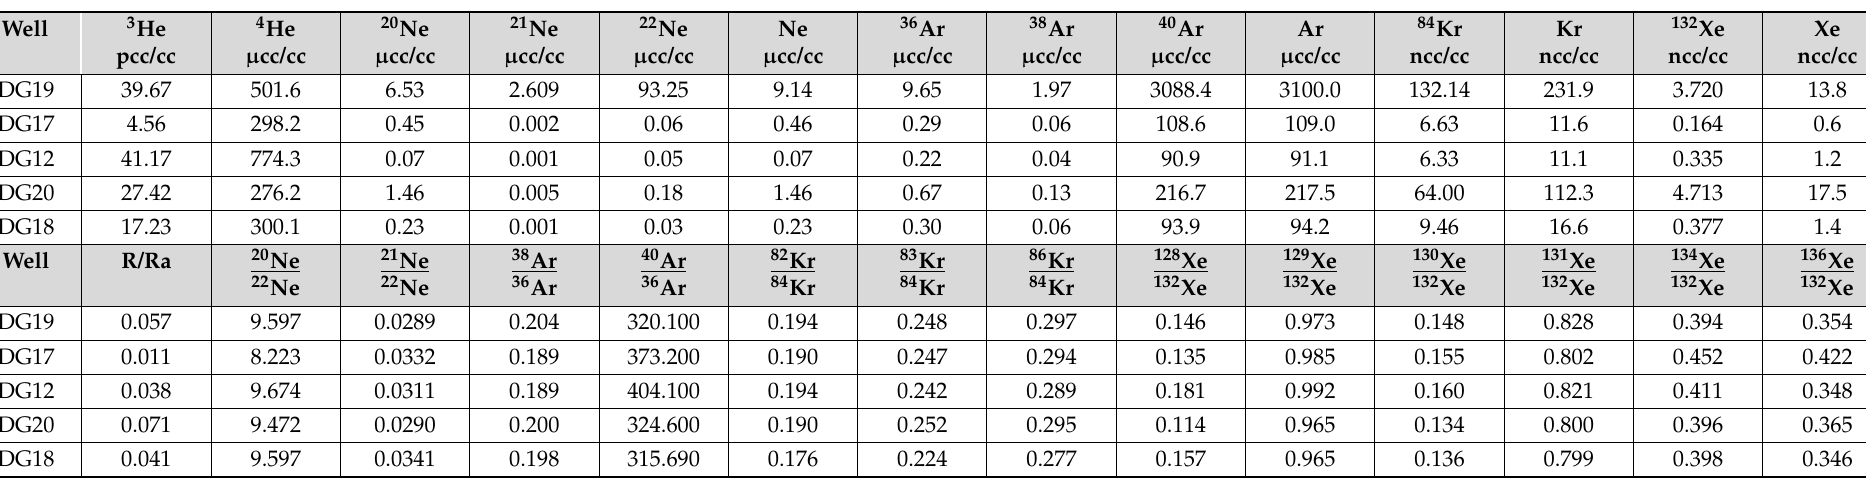
3 He/ 4 He) air . Selected characteristic noble gas measured /(